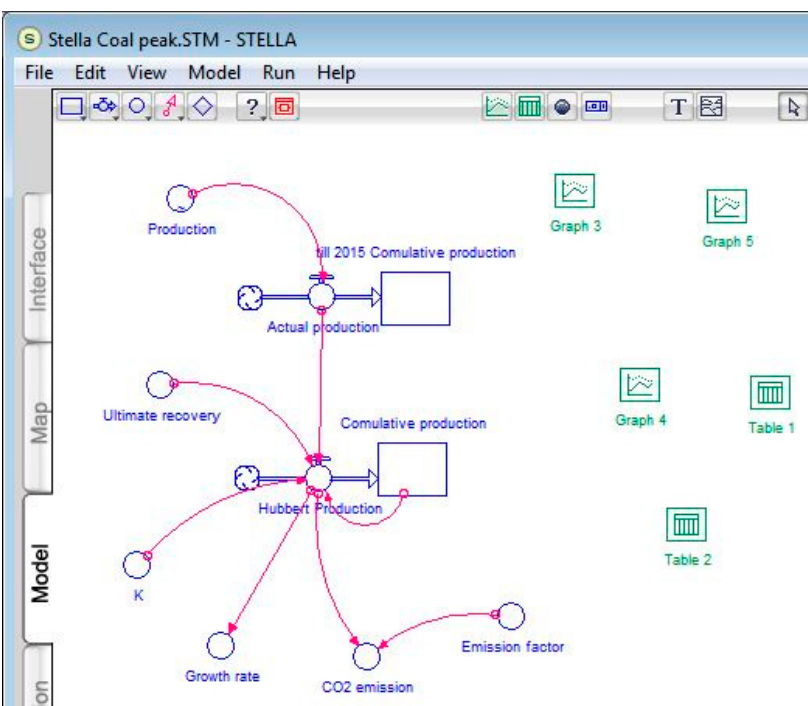
Figure 8. The STELLA interface depicting the Hubbert production as a flow.